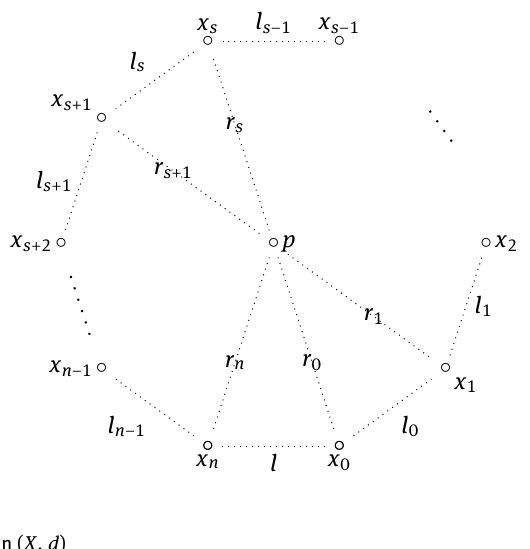
Figure 1: The view of the θ -chain in ( X , d